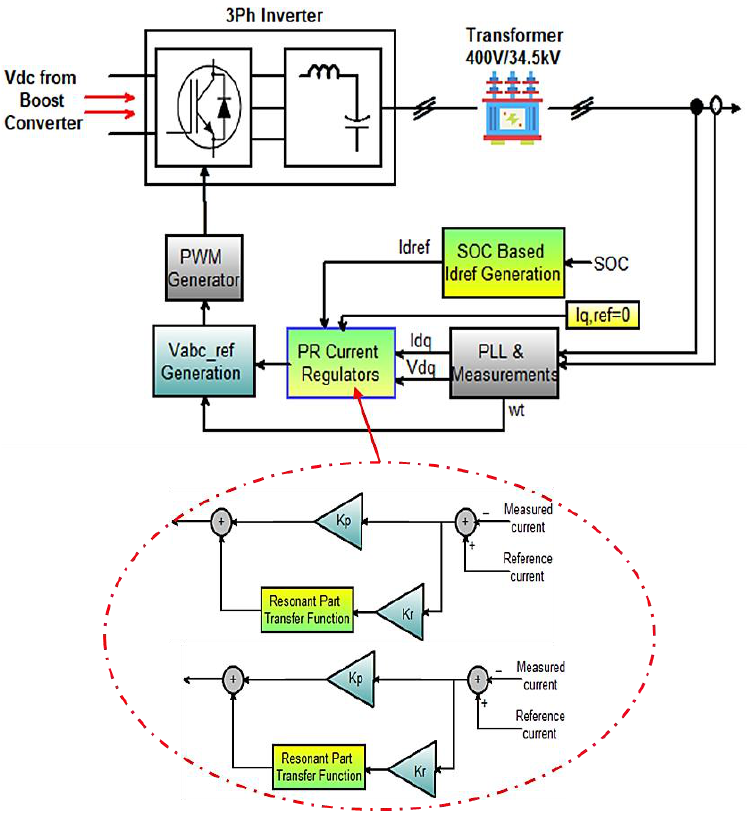
Figure 4. The control diagram of the main converter. To allow for a seamless exchange of power between DC and AC buses and the injec- tion/withdrawal of a predetermined amount of power to/from the AC link (utility grid), a PR control is used to implement a current-controlled voltage source for the main